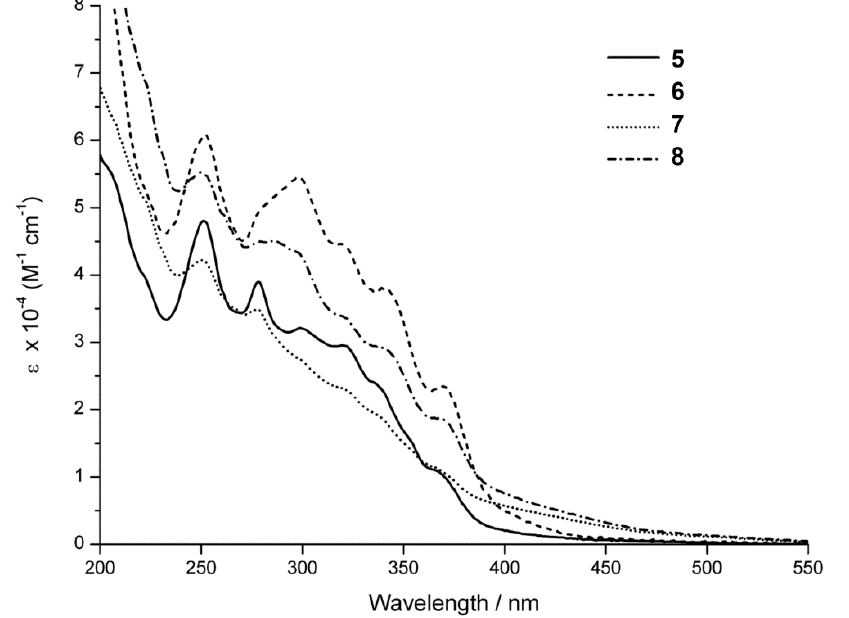
Figure 1. Room-temperature absorption spectra of acetonitrile solutions of 5 – 8 .